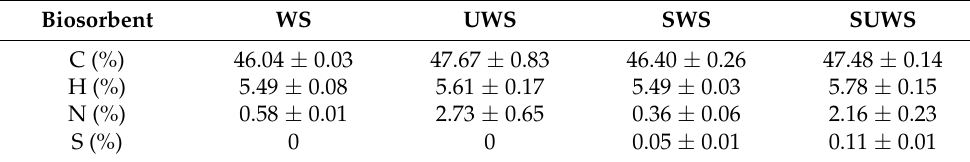
Table 4. Carbon, hydrogen, nitrogen and sulfur content in walnut shell